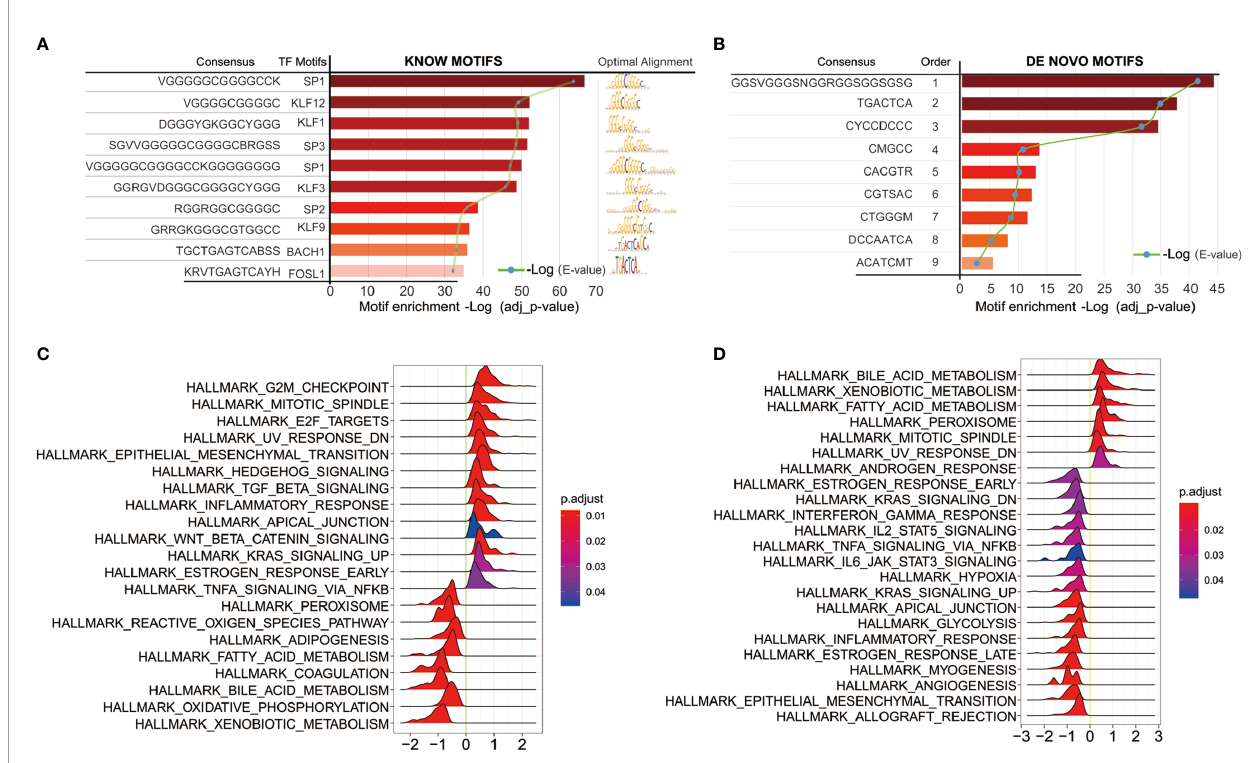
FIGURE 6 | Motif annotations of different peaks (A) known motif, (B) de novo motif ( Supplementary Table 8 ), and related motif transcription factor survival analysis results ( Supplementary Table 9 ); (C) SP1 Single Gene GSEA Analysis of Transcription Regulators; (D) Single Gene GSEA Analysis of KLF12 Transcription